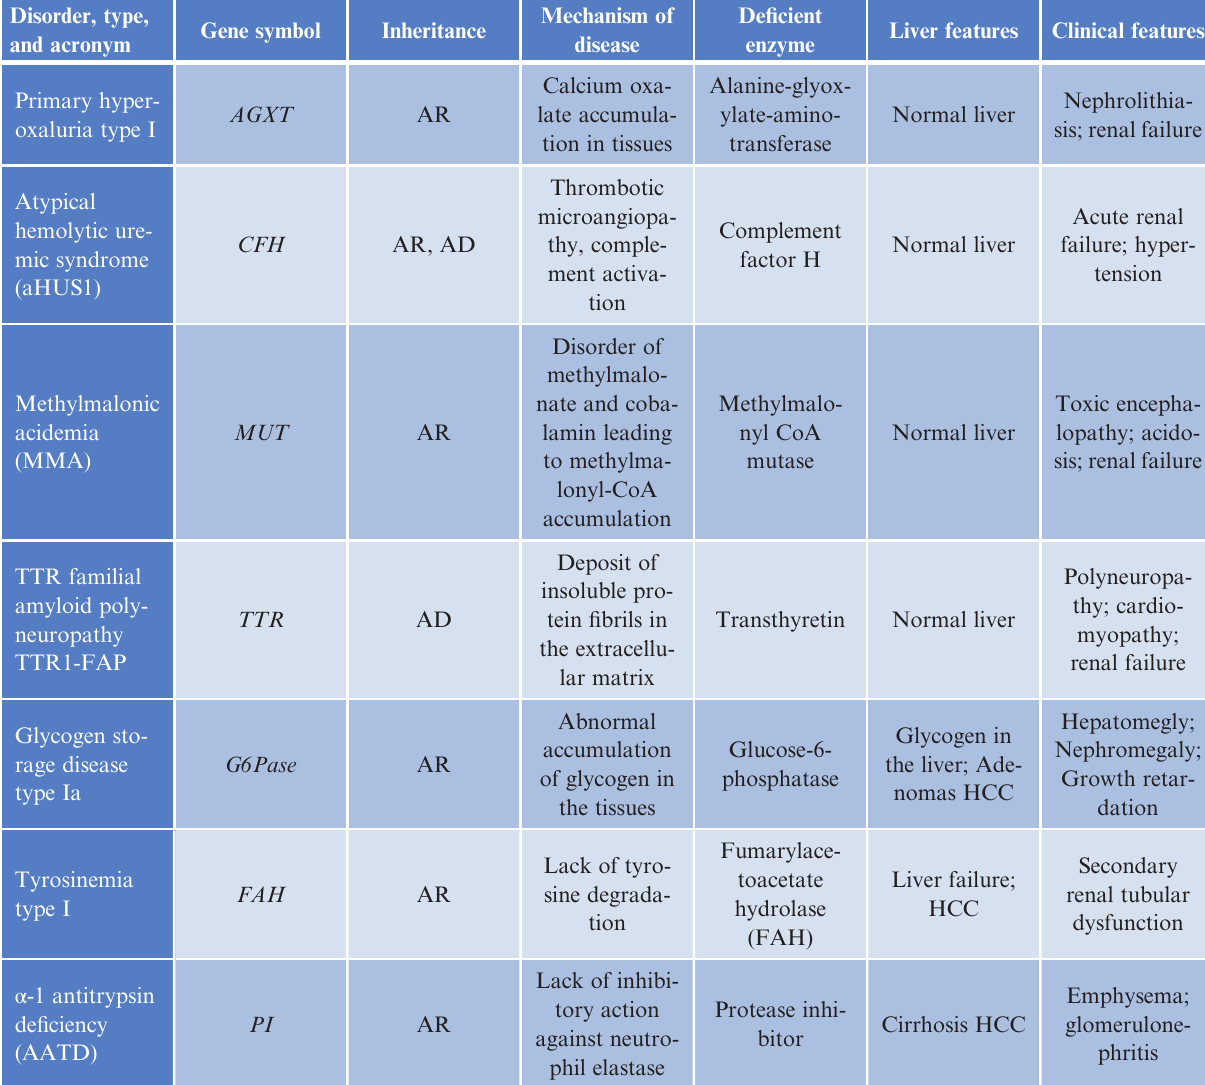
Table 2. Diseases involving the kidney amenable to LTA or CLKT as surgical therapy Disorder, type, and